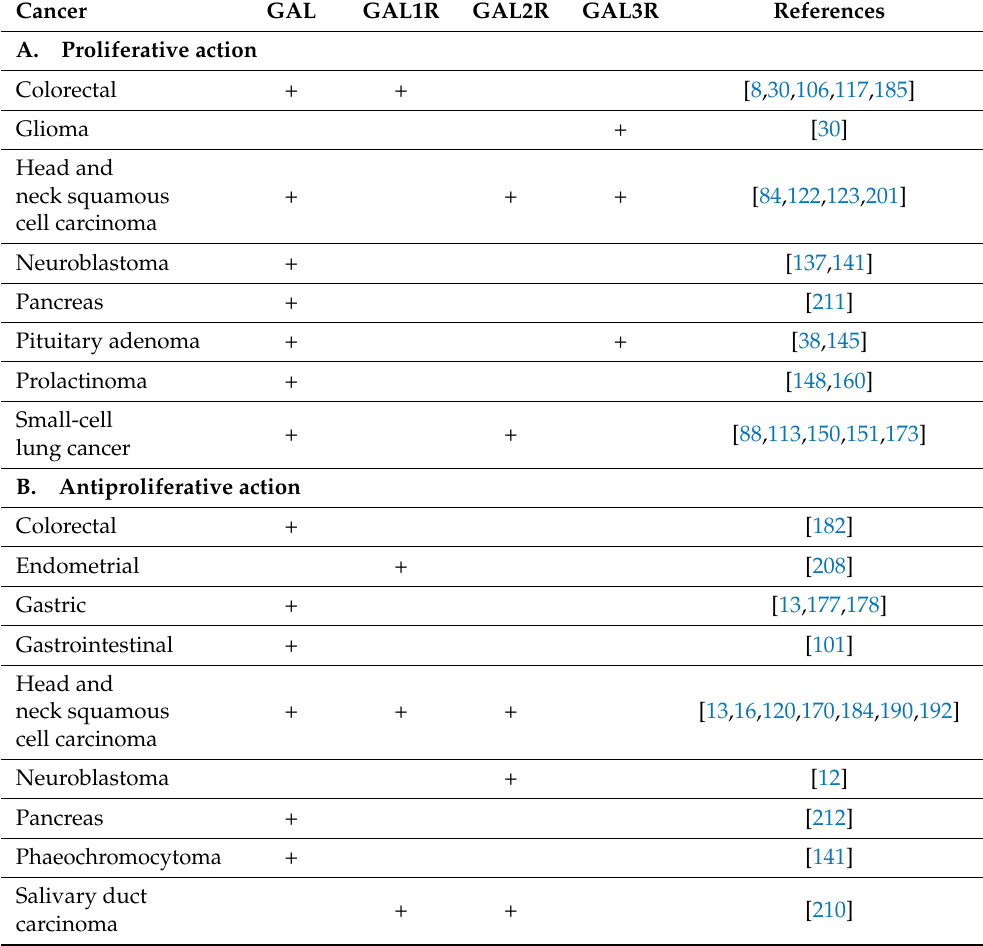
Table 6. Proliferative and antiproliferative actions of the galaninergic system in different tumors. +: action mediated by GAL, GAL 1 R, GAL 2 R or GAL 3